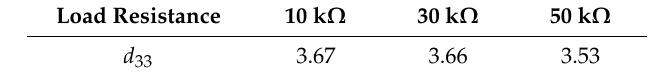
Table 1. Values of the d 33 coefficients (pC/N) for electrospun spider silk nanofibers.